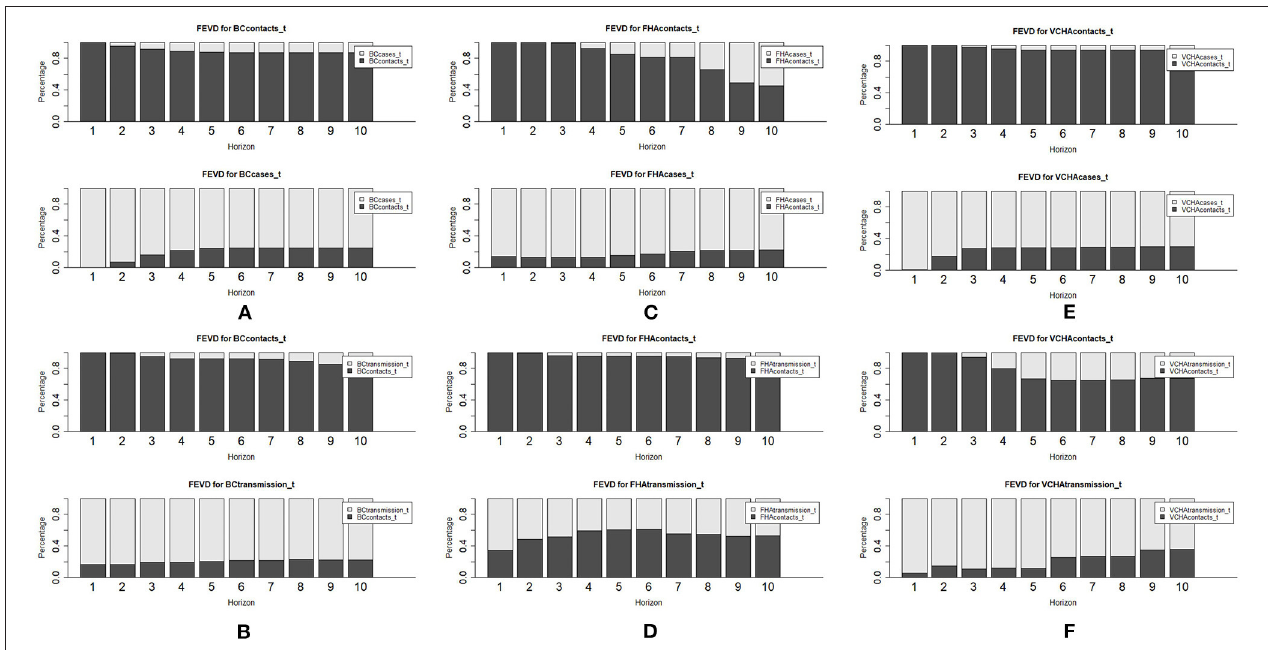
FIGURE 2 | Forecast error variance decomposition (FEVD) results for VAR models of average daily contacts and cases and average daily contacts and transmission in BC (A,B), FHA (C,D) , and VCHA (E,F) .